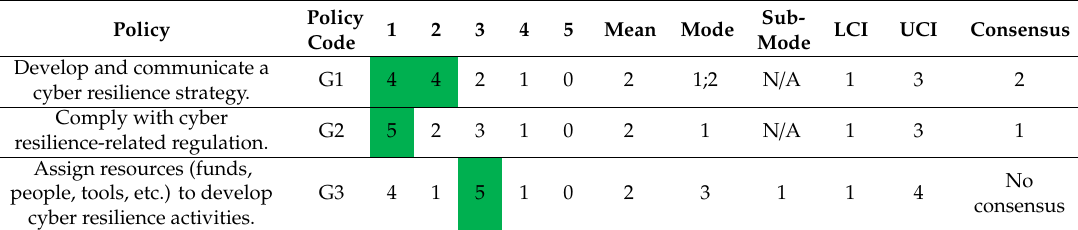
Table 2. Governance policies’ starting maturity.